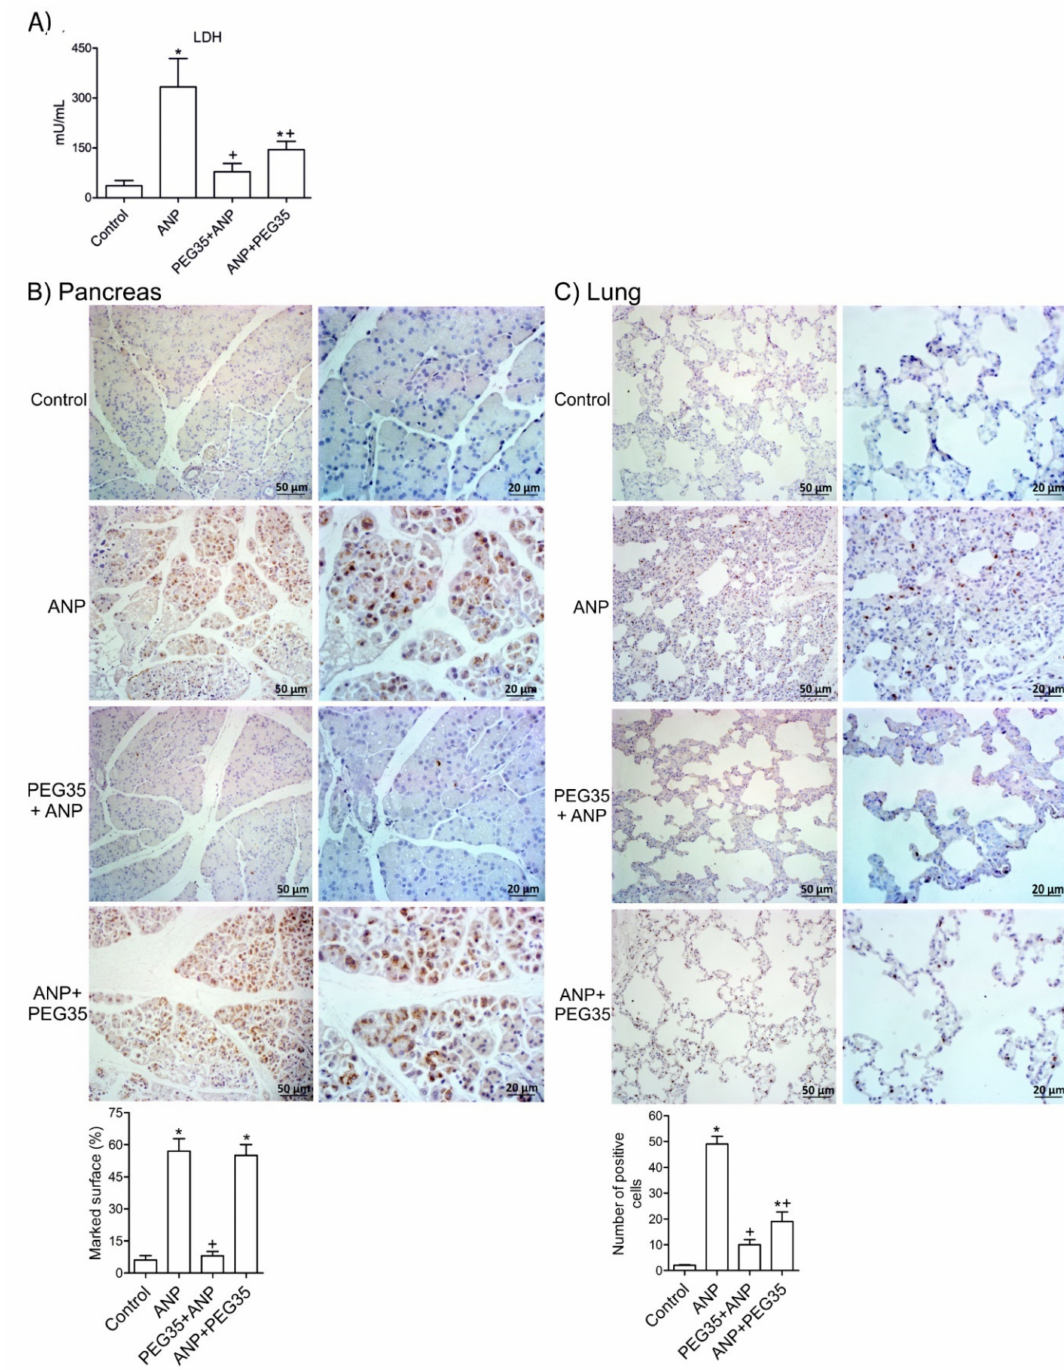
Figure 6. E ff ects of PEG35 treatment on ANP-induced cell death. ( A ) Plasma lactate dehydrogenase activity three hours after acute necrotizing pancreatitis induction expressed as mU / mL. ( B ) Top: Representative images of pancreatic sections stained with anti-cleaved caspase-3 antibody (brown). Bottom: Pancreas cleaved caspase-3 immunostaining quantification represented as the percentage of marked surface per field. ( C ) Top: Representative images of lung sections stained with anti-cleaved caspase-3 antibody (brown). Bottom: Pulmonary cleaved caspase-3 immunostaining quantification represented as the average number of positive cells per field. Bars represent mean values of each group ± SEM. * p < 0.05 versus Control, + p < 0.05 versus ANP. ANP, Acute Necrotizing Pancreatitis. PEG35, Polyethylene glycol 35. Each determination was carried out in